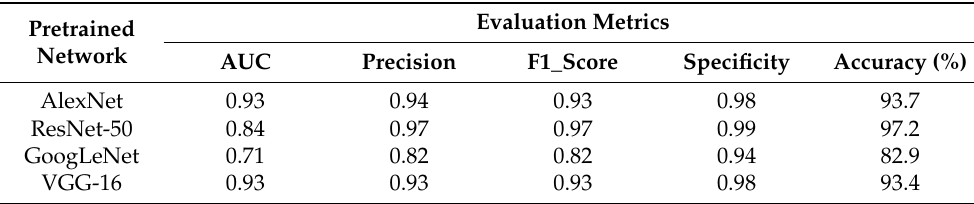
Table 3. Evaluation metrics for the pretrained